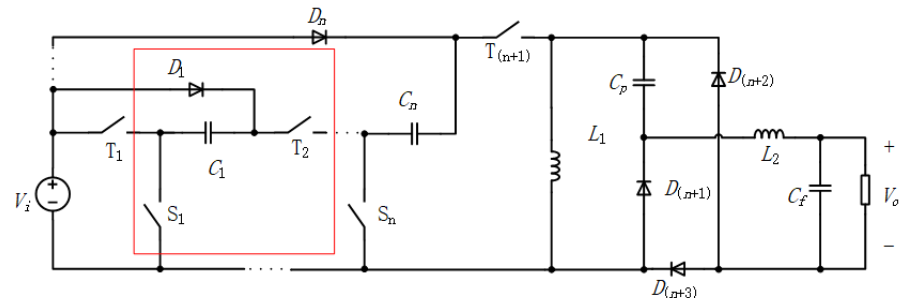
Figure 18. A switched-capacitor-based DC-DC converter.